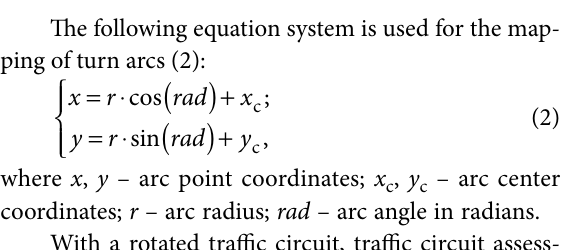
Fig. 8. Computer model of an unrotated flight traffic circuit